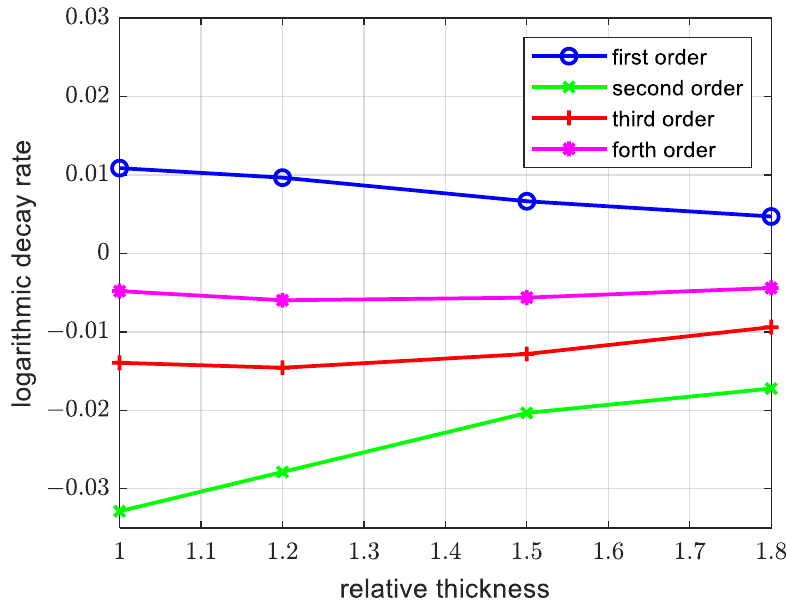
Figure 23. Variations in the logarithmic decay rate of the generalized displacement with the thickness of the shell (the relative thickness is equal to the thickness divided by the initial thickness).